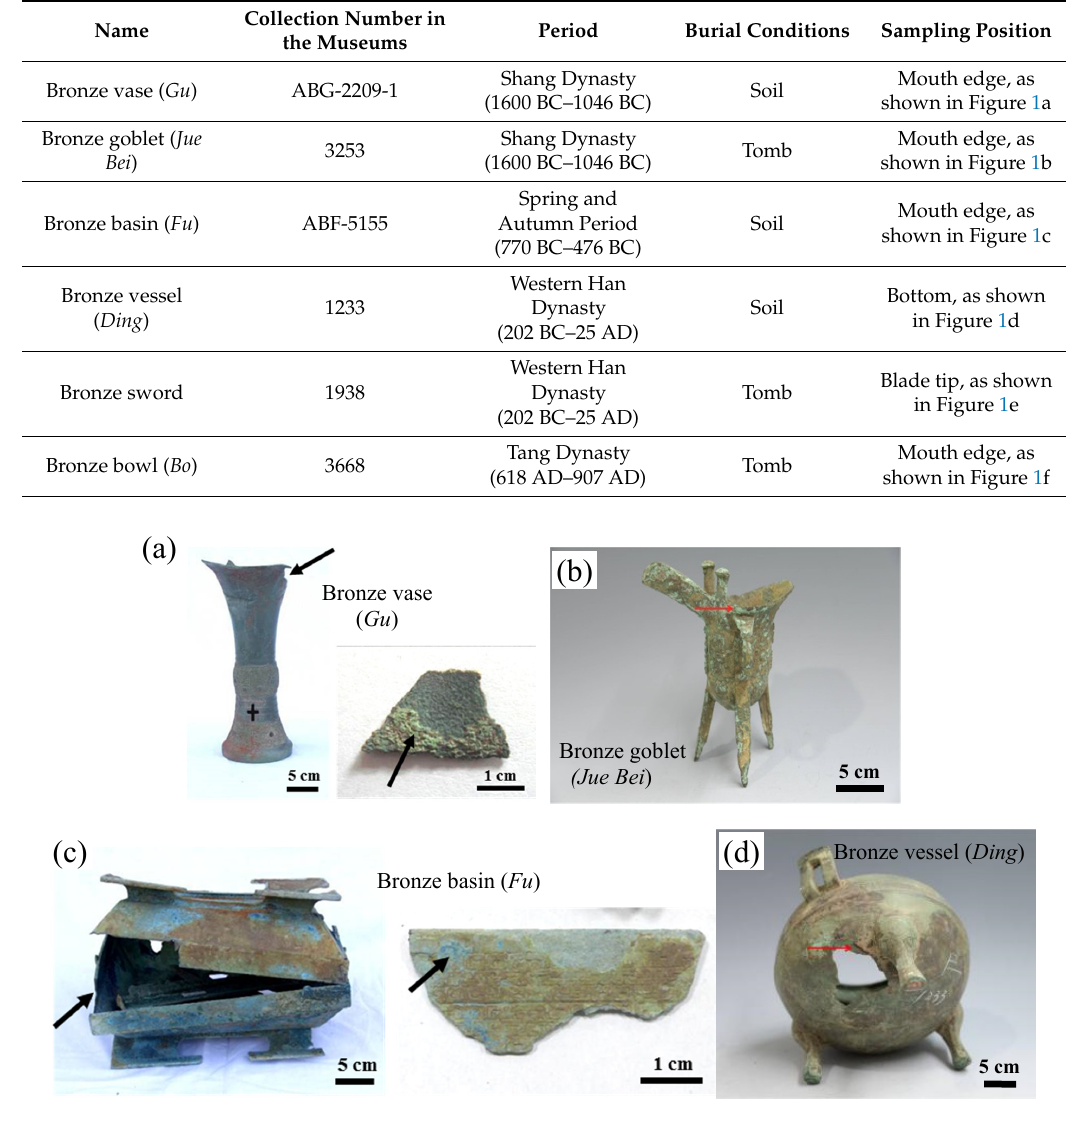
Table 1. Information of the ancient bronzes.